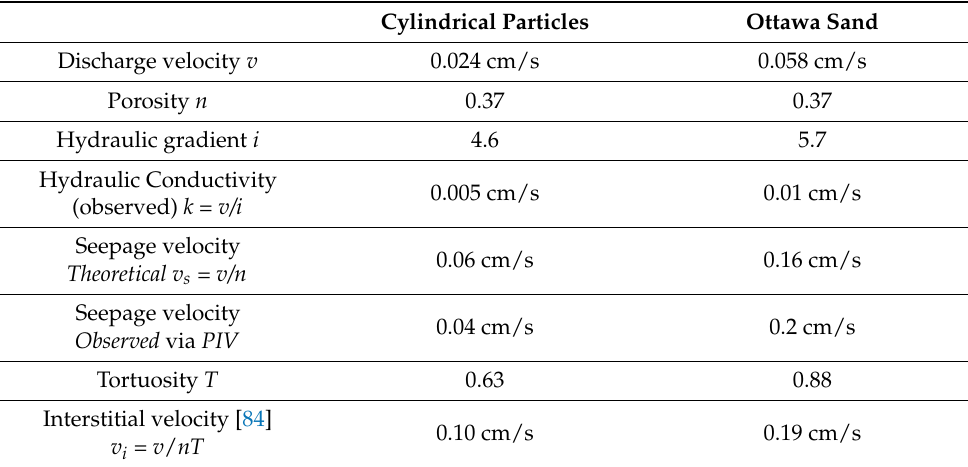
Table 1. Average seepage velocity